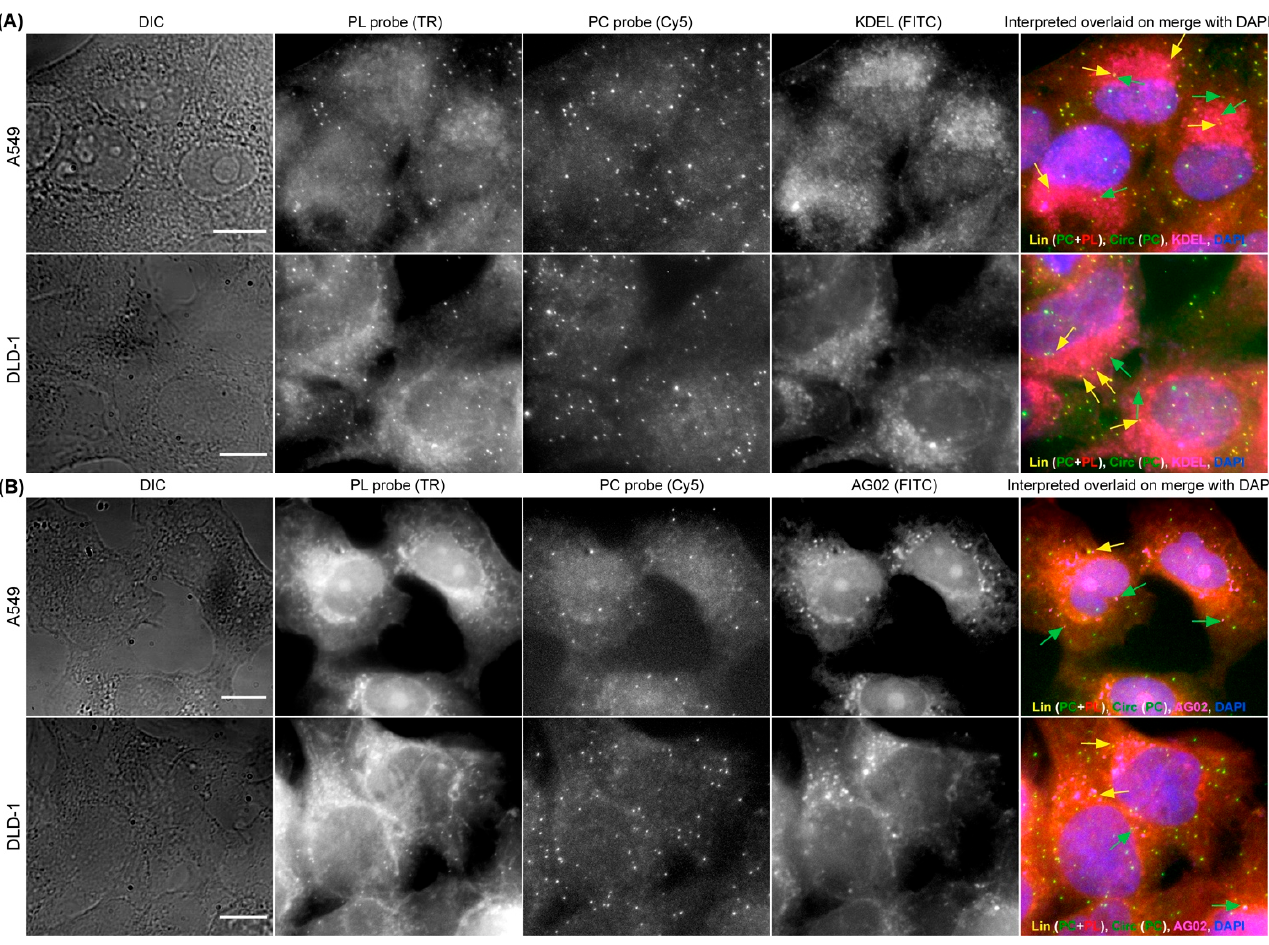
Figure 5. CircFISH in combination with immunofluorescence. ( A ) Representative image panel of A549 and DLD-1 cells treated with PL and PC probes for circFISH of ZNF609, as well as with antibodies against KDEL for ER staining. From the left: DIC; raw merged z stacks of cells for PL ZNF609 probes labeled with TR; raw merged z stacks of cells for PC ZNF609 probes labeled with Cy5; raw merged z stacks of cells for KDEL antibodies tagged with AF488; and a merged image of the three channels with the TR spots colored red, Cy5 colored green and AF488 colored pink, overlaid on DAPI with arrows showing circZNF609 (green) and ZNF609 (yellow) co-localizing with KDEL (pink). ( B ) Representative image panel of A549 and DLD-1 cells treated with PL and PC probes for the circFISH of CSNK1G3, as well as with antibodies against AGO2. Columns from the left: DIC; raw merged z stacks of cells for PL CSNK1G3 probes labeled with TR; raw merged z stacks of cells for PC CSNK1G3 probes labeled with Cy5; raw merged z stacks of cells for AGO2 antibodies tagged with secondary FITC; and a merged image of the three channels with TR spots colored red, Cy5 colored green and FITC colored pink, overlaid on DAPI with arrows showing circCSNK1G3 (green) and CSNK1G3 (yellow) co-localizing with AGO2 (pink). The scale bar is 5 µ